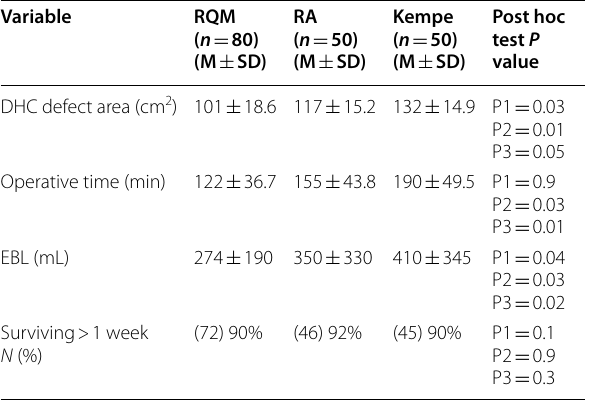
Table 2 Outcome variables among patient groupings